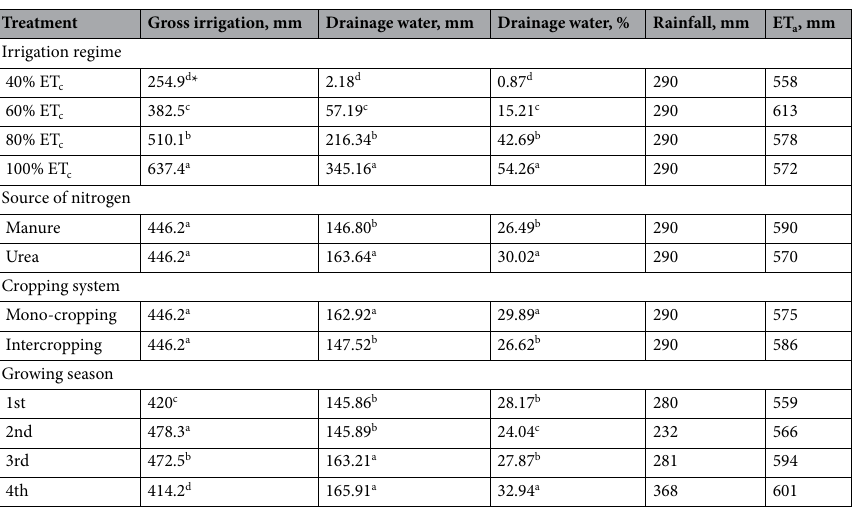
Table 2. Means for seasonal drainage water, gross irrigation, rainfall and actual evapotranspiration, ETa, depths. *Means followed by similar letters in each column for each factor and each trait are not significantly different at 5% level of probability according to Tukey